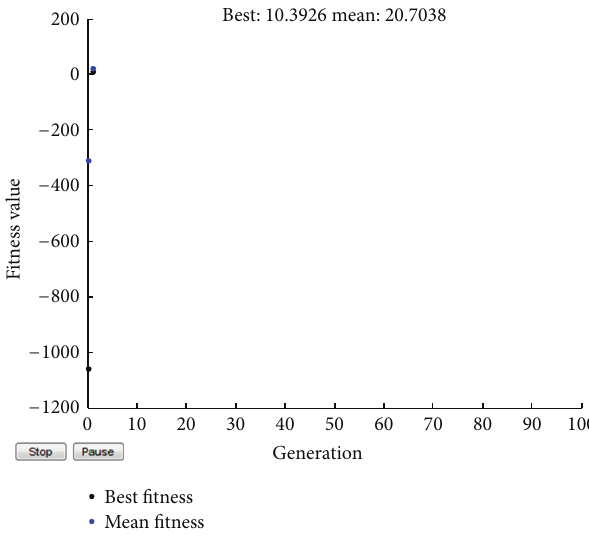
Figure 9: Fitness value of GA